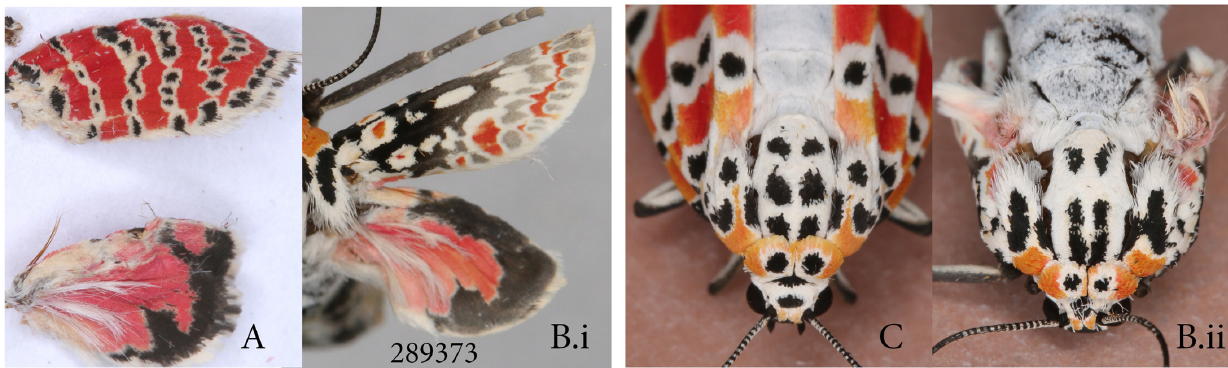
Figure 12. Maximum extent of heparin-induced wing pattern changes in the ornate bella moth, Utetheisa ornatrix. ( A ) control specimen dissected out of a pupa, wings not spread. ( B ) injected 0.5 ul of 3% (0.015 mg) heparin as pupa11hAP. ( C ) typical specimen from the control group. ( i ) dorsal ( ii ) head and